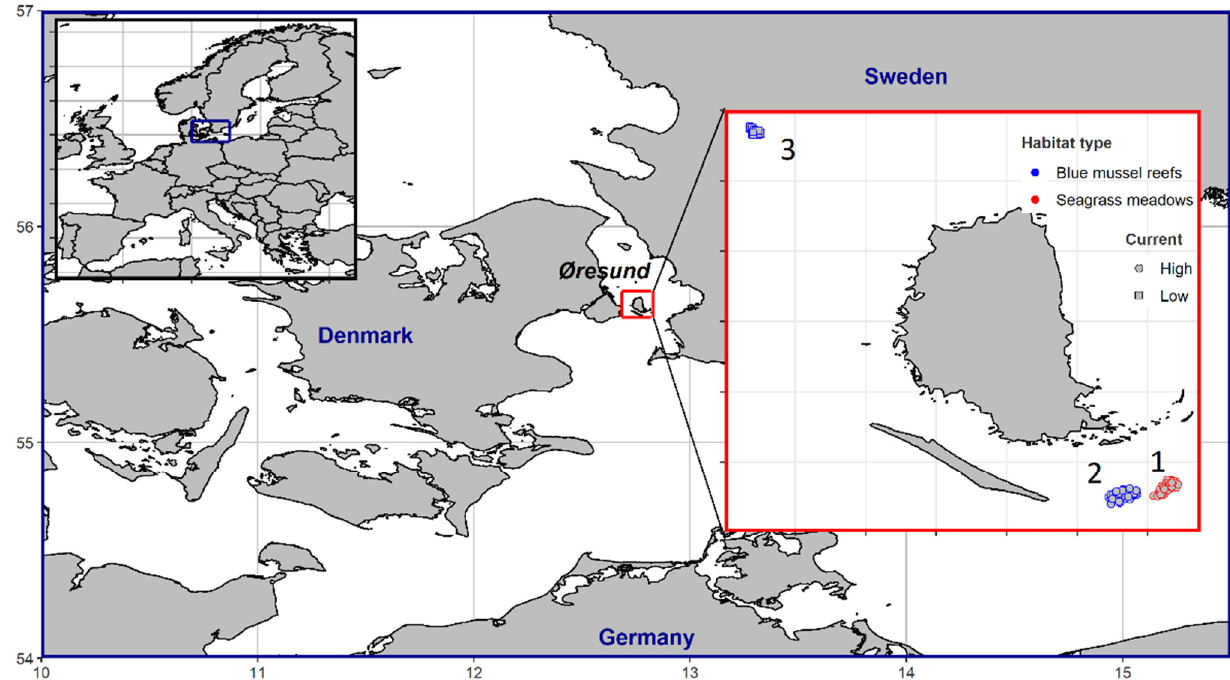
Figure 1. Map of the sampling area and sites. The red color dots indicate the seagrass meadows (field site 1), while the blue color dots indicate the mussel reefs. For the mussel reefs, circles refer to high water currents (field site 2) and squares refer to low water currents (field site 3).